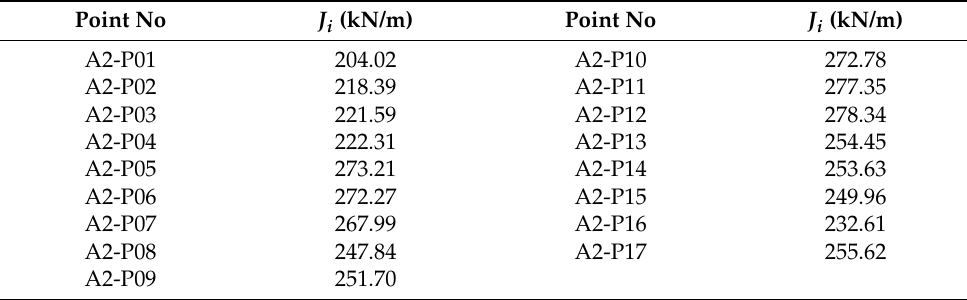
Table 7. The results of the J i parameter for full-scale experiment at the calculation points.